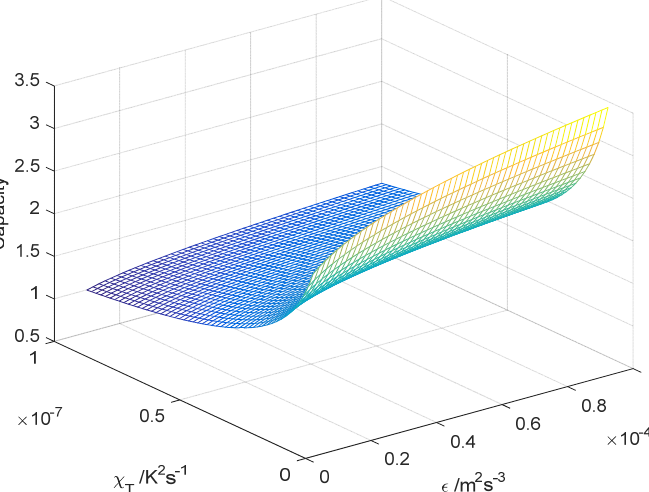
Figure 10. Channel capacity of the link with the random double-position power Gaussian vortex carrier optics communication system versus dissipation rate of kinetic energy per unit mass of fluid ε and dissipation rate of the mean-squared temperature χ T